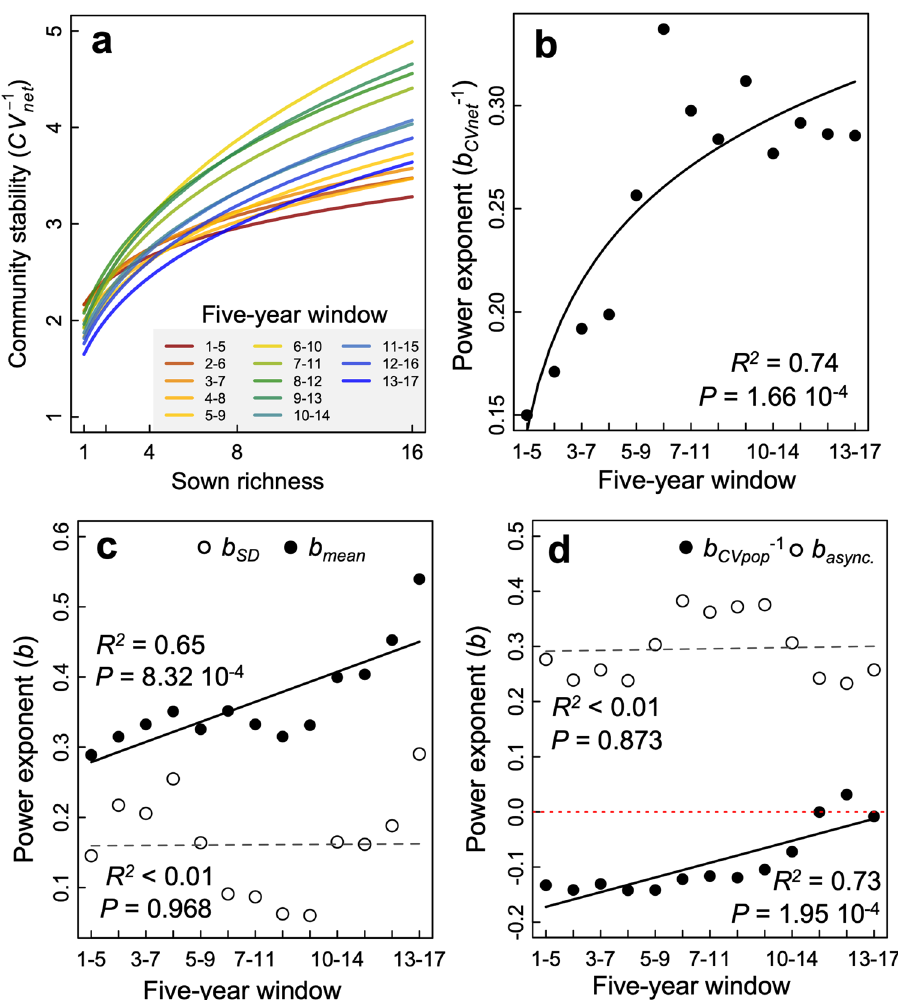
Fig. 3 | Effects of species richness on community stability and its underlying components. In a the richness-community stability (CV net − 1 ), relationships are sown for each 5-year window indicated by different colors (1=2003, 17=2019). b The change in the slope of the log – log relationship between richness and com- munitystability(powerexponent b ofcurvesshownin a foreachconsecutive5-year rolling window. The solid regression line was fi t using the relationship slope~- log(window).Similarly, c aretheregressioncoef fi cientsofrichnessonthe fi ve-year